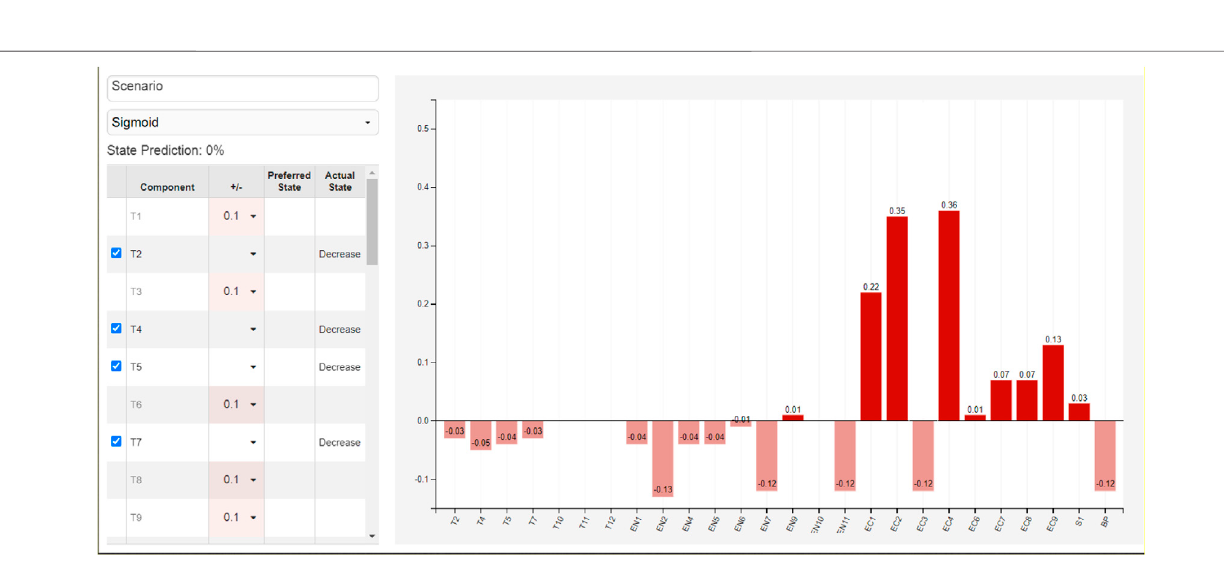
Frontiers in Energy Research |